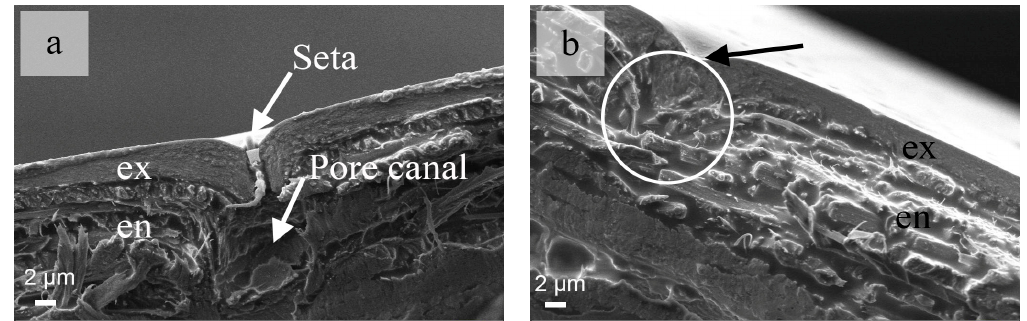
Figure 3. Cross-sectional SEM images of the C. septempunctata L. elytra. ( a ) seta and pole canal in the cuticle and ( b ) deformation of fiber layers (in white circle).